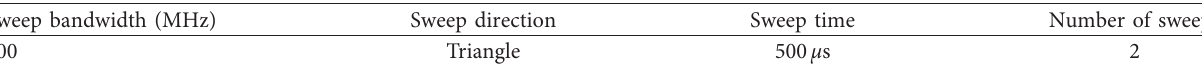
Table 11: FMCW signal parameters.